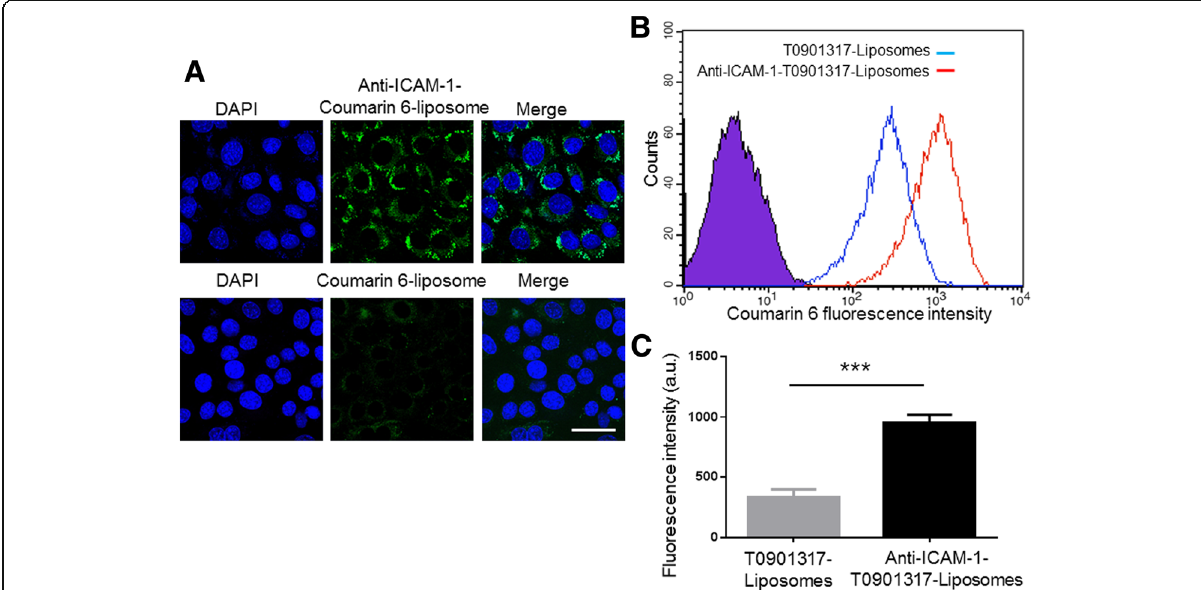
Fig. 5 Cellular uptake and targeting efficiency of coumarin-6 in liposomes. a CLSM images of MOVAS cells pre-treated for 24 h with PDGF-BB (20 μ g/mL), followed by incubation with anti-ICAM-1-coumarin-6 liposomes, or coumarin-6 liposomes for 4 h. Left column DAPI channel showing blue fluorescence, middle column coumarin-6 channel showing green fluorescence from the liposomes, right column merged channel showing DAPI and coumarin-6. Bars = 50 μ m. b Flow cytometry analyses of MOVAS cells pre-treated for 24 h with PDGF-BB (20 μ g/mL) followed by treatment with anti-ICAM-1-coumarin-6 liposomes or coumarin-6 liposomes for 4 h. Emitted light was collected at FL6 using a 660/20-nm band pass filter. c Mean coumarin-6 fluorescence intensities obtained from MOVAS cells pre-treated for 24 h with PDGF-BB (20 μ g/mL) and incubated with anti-ICAM-1-cou- marin-6 liposomes or coumarin-6 liposomes for 4 h. Values are expressed as the means ± SD ( n = 3); ** P < 0.01